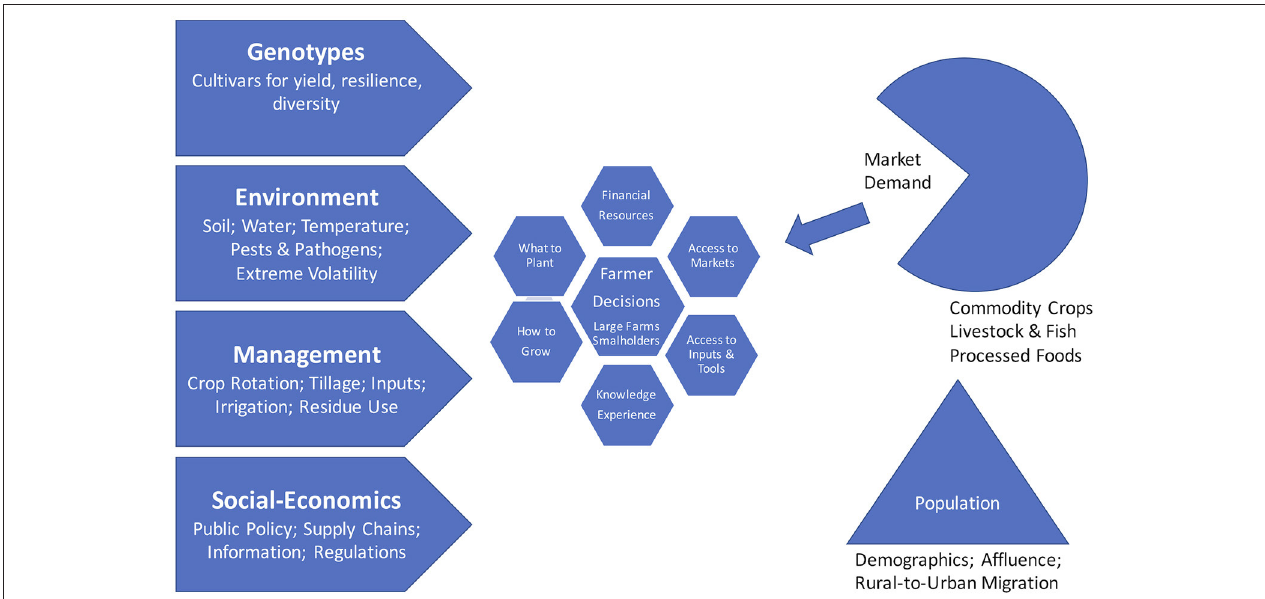
FIGURE 1 | Schematic representation of cereal production as a social-ecological system. The domains of environmental conditions of soil quality, precipitation, fresh water access, temperatures, pest pressures, and extreme weather events; genotype properties of cultivars, annuals, perennials, root structure; biological N fixing; stress tolerance; agronomic management of crop diversity, tillage, input use, livestock integration, residue retention, and social-economic factors that affect market demand, price signals, capital investment, public incentives, regulations, research; and cultural customs and attitudes all interact to establish the context, motivation, and resources that influence farmers’ decisions concerning how to adapt to changing climate